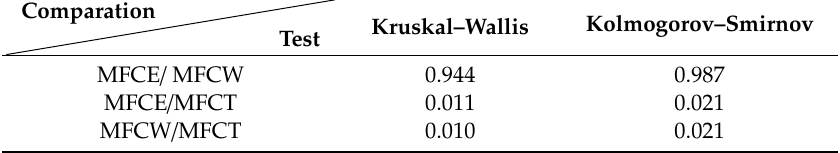
Table 1. Kruskal–Wallis and Kolmogorov–Smirnov tests for the COD removal efficiencies. Comparation